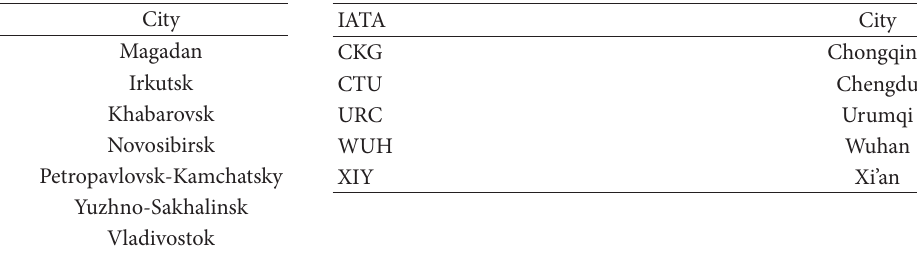
Table 4: Russian airports. Table 5: Chinese